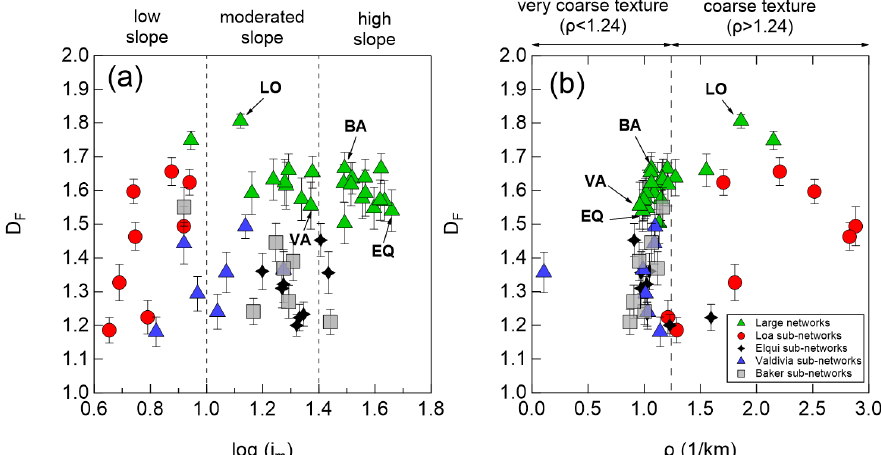
Figure 6. Fractal dimension D F versus ( a ) the slope and ( b ), the drainage density of each basin. In ( a ) three regions separate the slopes of the basin. In ( b ) two regions were drawn: ρ ≤ 1.24 km − 1 (very coarse texture) and ρ > 1.24 km − 1 (coarse drainage texture). Loa, Elqui, Valdivia and Baker networks were explicitly indicated to emphasize the differences between large and sub-networks. Error bands of each data ( ∆ F ) were included for